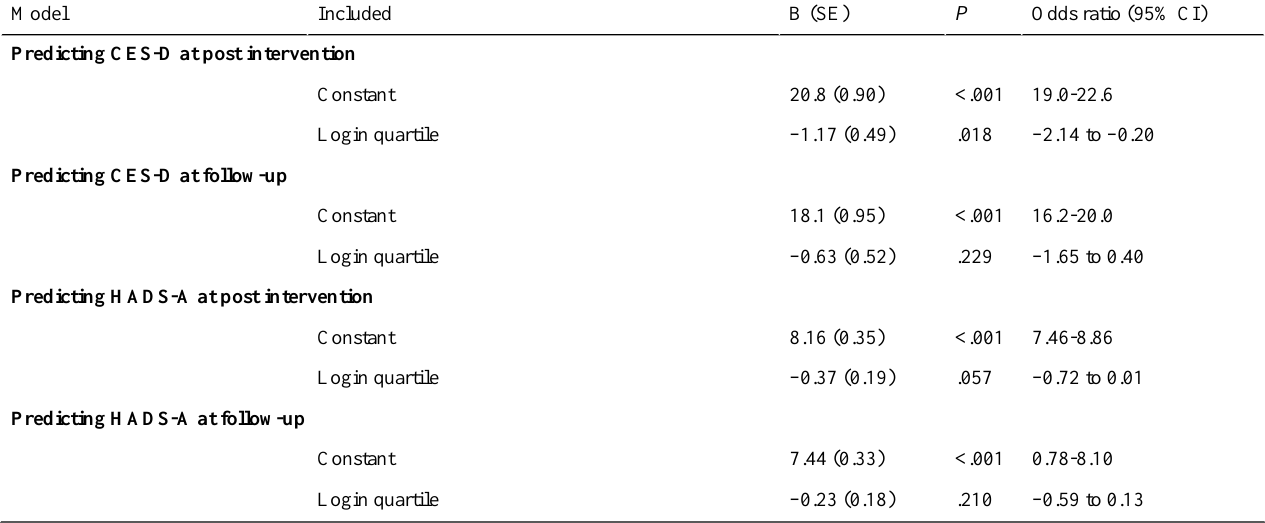
Table 4. Linear regression with login quartiles as